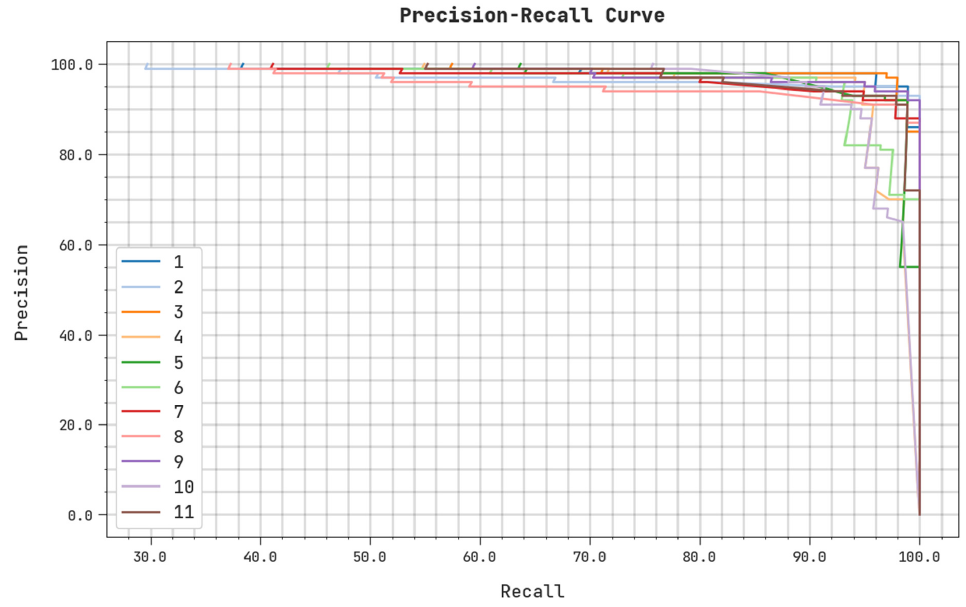
Figure 8. Precision-recall analysis ASODCAE-SLR approach.